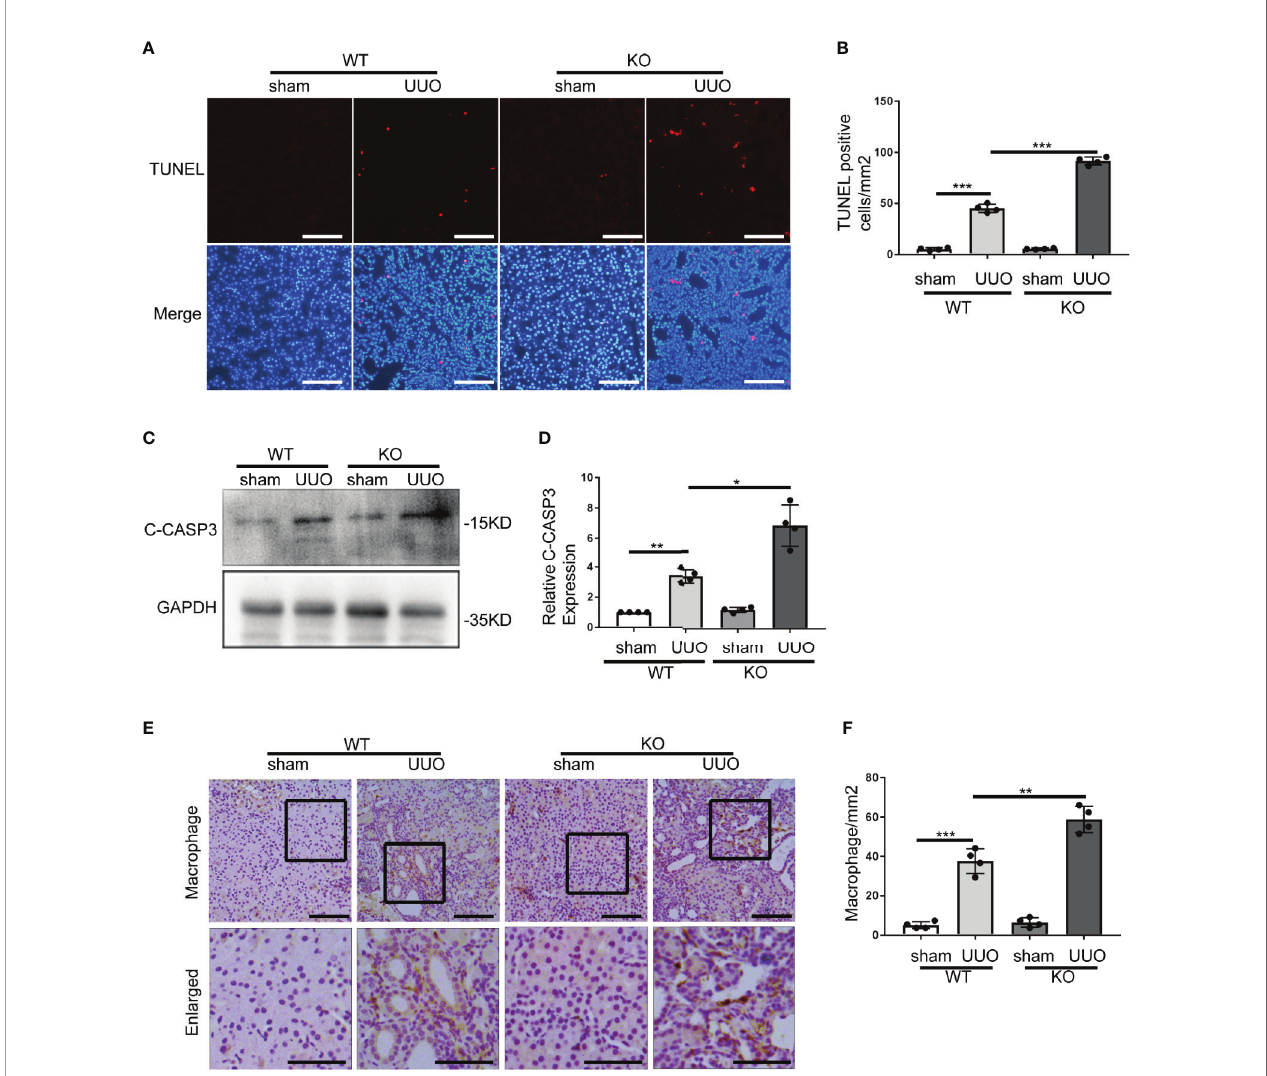
FIGURE 3 | Park7 de fi ciency increases tubular cell apoptosis and in fl ammation in UUO. Animals and their treatment were the same as described in Figure 2 . (A) Representative images of TUNEL analysis of kidney tissues. Bar:100 m m. (B) Quanti fi cation of TUNEL-positive cells in kidney tissues(n=4). (C) Representative immunoblots of cleaved/activated caspase3 (C-CASP3) and GAPDH(as a loading control). (D) Densitometry of C-CASP3 signals(n=4). The signal of C-CASP3 was normalized to the GAPDH signal of the same samples to determine the ratios. The values are expressed as fold change over sham control in WT mice. (E) Representative images of macrophage staining. Bar: 100 m m in the top images and 50 m m in the bottom enlarged images. (F) Quanti fi cation of macrophage -positive cells(n=4). Each symbol (circle) represents an individual mouse. Error bars: SEM. *p < 0.05, **p < 0.01, ***p <